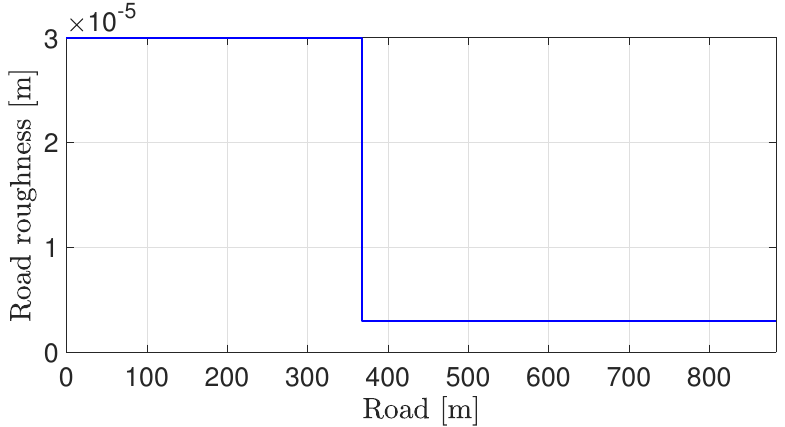
Figure 25. Road roughness. Again, we see from Figure 26 that the new reference speed is calculated, and the cruise control effectively tracks this value. The resulting road displacement z r significantly decreases after 40 s (around 360 m) due to the change in road type (only the displacement at the front right corner of the vehicle is shown in Figure